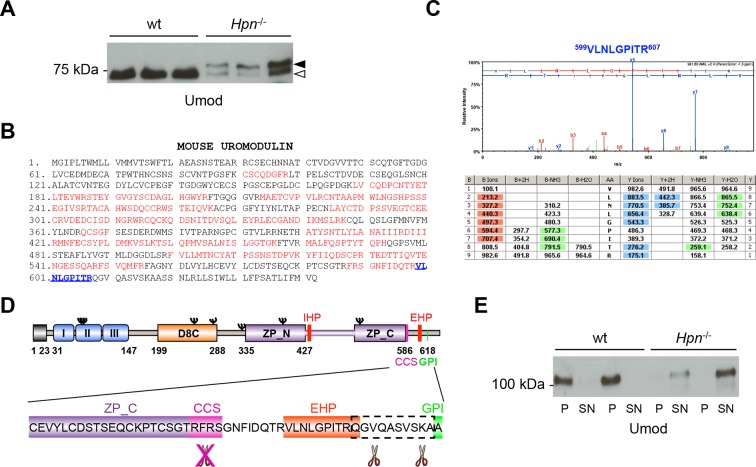
Absence of hepsin in vivo abolishes physiological cleavage and polymerisation of uromodulin.(A) Representative Western blot analysis of N-deglycosylated urinary uromodulin secreted by Hpn-/- mice or control animals. Hpn-/- mice show the presence of two uromodulin isoforms: a short one with similar electrophoretic mobility as in wild-type urines (white arrowhead), and a longer one that is absent in samples from wild-type mice (black arrowhead) (n = 6/group). (B) Mass spectrometry (MS) sequence coverage (52% over the entire protein) of trypsin-digested mouse uromodulin (short isoform) (UniProt accession Q91X17) purified from urine of Hpn-/- mice. Matching peptides are shown in red, while the C-terminal peptide is shown in blue. This peptide ends at R607, a distal C-terminal residue with respect to the one reported for mouse urinary uromodulin (F588 [Santambrogio et al., 2008]). (C) Representative tandem mass-spectrometry (MS/MS) spectrum, confirming the identity of the identified C-terminal peptide (599VLNLGPITR607) of the short uromodulin isoform released by Hpn-/- mice, and table of fragmented ions. (D) Schematic representation of mouse uromodulin domain structure as in Figure 1A. The blow-up shows that in the absence of hepsin, the cleavage generating the short uromodulin isoform is abolished and alternative ones at more C-terminal sites (distal to R607) take place. (E) Representative Western blot analysis of uromodulin in supernatant (SN) and pellet (P) fractions from a polymerisation assay performed on urinary samples from Hpn-/- mice or control animals. Urinary uromodulin from control animals is precipitated in the pellet fraction, reflecting full engagement in polymeric structures, while the one from Hpn-/- mice is only detected in the supernatant (n = 4/group).DOI:
http://dx.doi.org/10.7554/eLife.08887.02010.7554/eLife.08887.021Figure 7—source data 1.Transcript level of Prss8 in mouse microdissected nephron segments (Figure 7—figure supplement 2A).DOI:
http://dx.doi.org/10.7554/eLife.08887.02110.7554/eLife.08887.022Figure 7—source data 2.Quantification of urinary uromodulin secretion in Prss8-/- and control mice (Figure 7—figure supplement 2C).